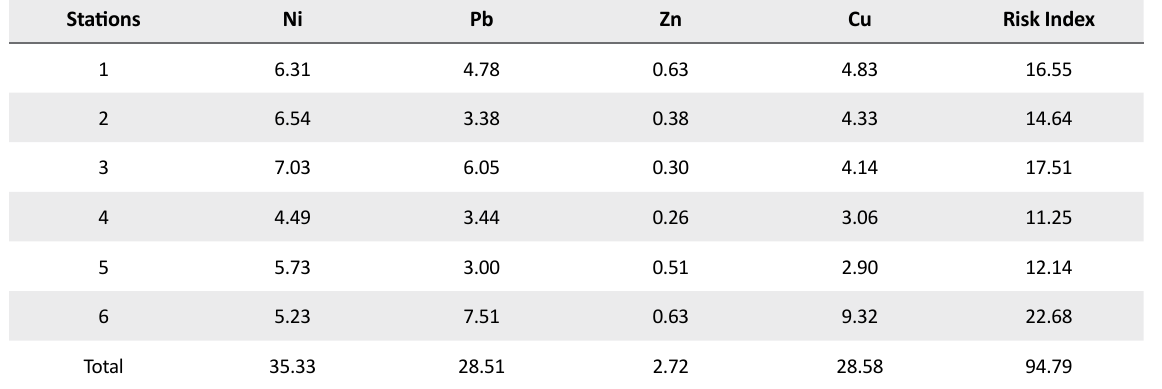
Table 4. Results of ecological and environmental hazard index values for metals measured at different stations